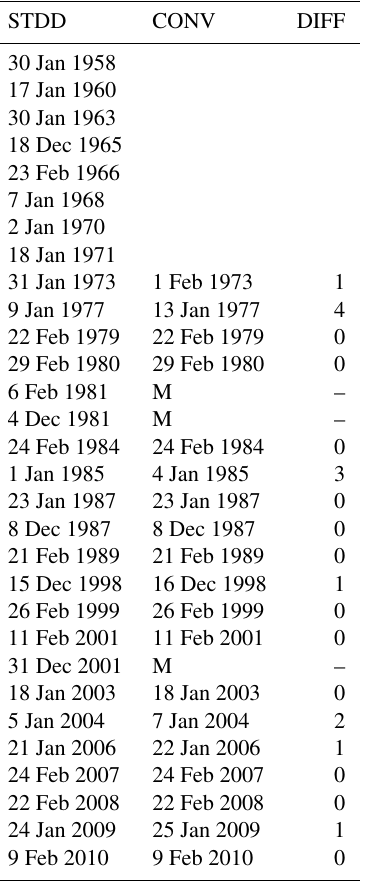
Table 1. Onset dates of DJF MSSWs for STDD and CONV, with differences in the onset dates (number of days) of CONV from STDD. Empty cells indicate the period when CONV is unavail- able. The “M” letters mean that the MSSWs identified in STDD are missed in CONV. STDD CONV